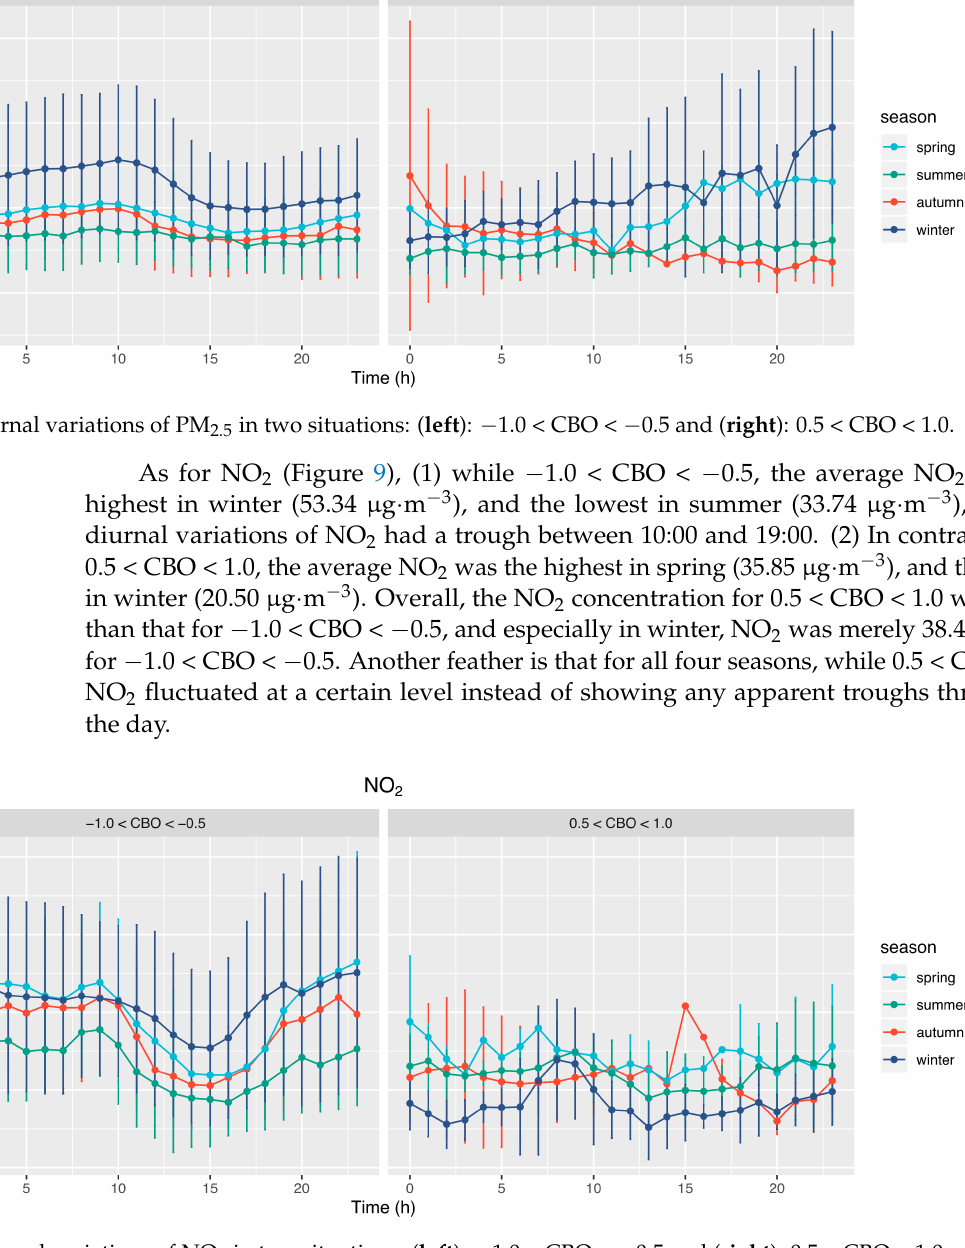
Figure 9. Diurnal variations of NO 2 in two situations: ( left ): − 1.0 < CBO < − 0.5 and ( right ): 0.5 < CBO < 1.0. As shown in Figure 10, In both cases ( − 1.0 < CBO < − 0.5 and 0.5 < CBO < 1.0), the difference in SO 2 mass concentrations was not significant, and in winter, SO 2 was slightly lower for − 1.0 < CBO < − 0.5 than for 0.5 < CBO <